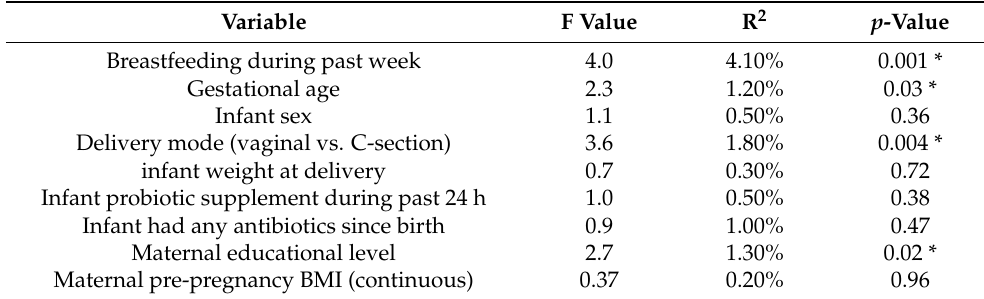
Table 3. Results of Permutational Multivariate Analysis of Variance (PERMANOVA) 1 with 999 permutations for all